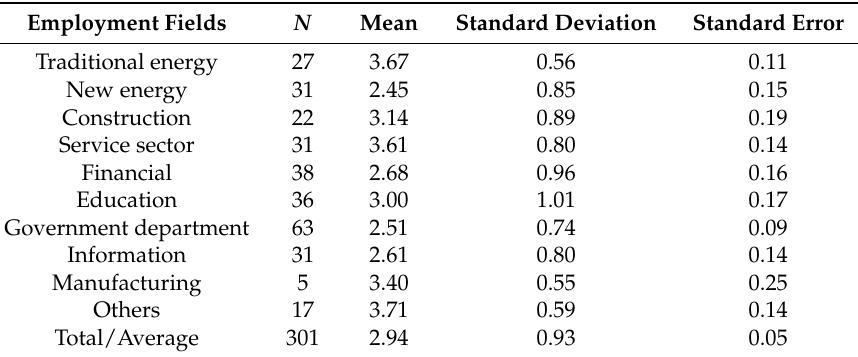
Table 9. Description of employment fields.